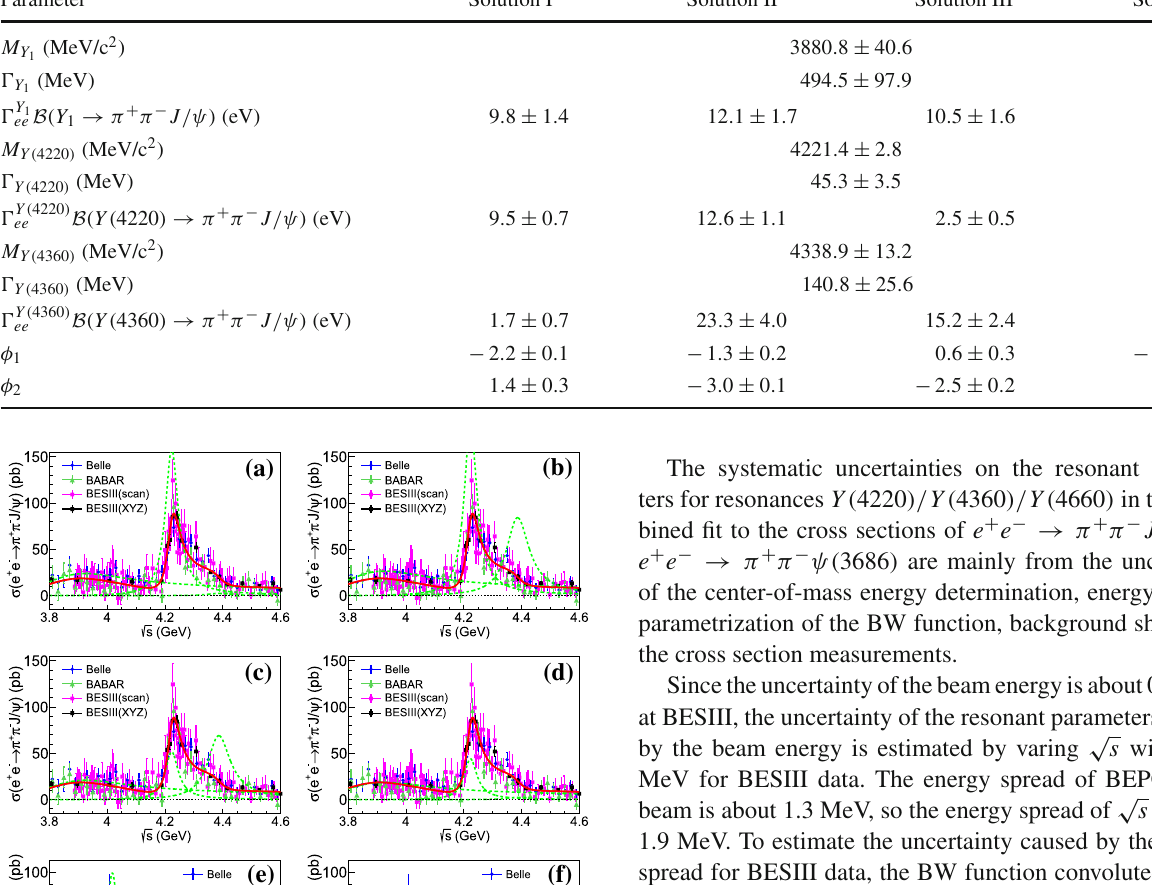
Table 1 The fitted parameters of the cross section of e + e − → π + π − J /ψ . The errors are statistical Parameter